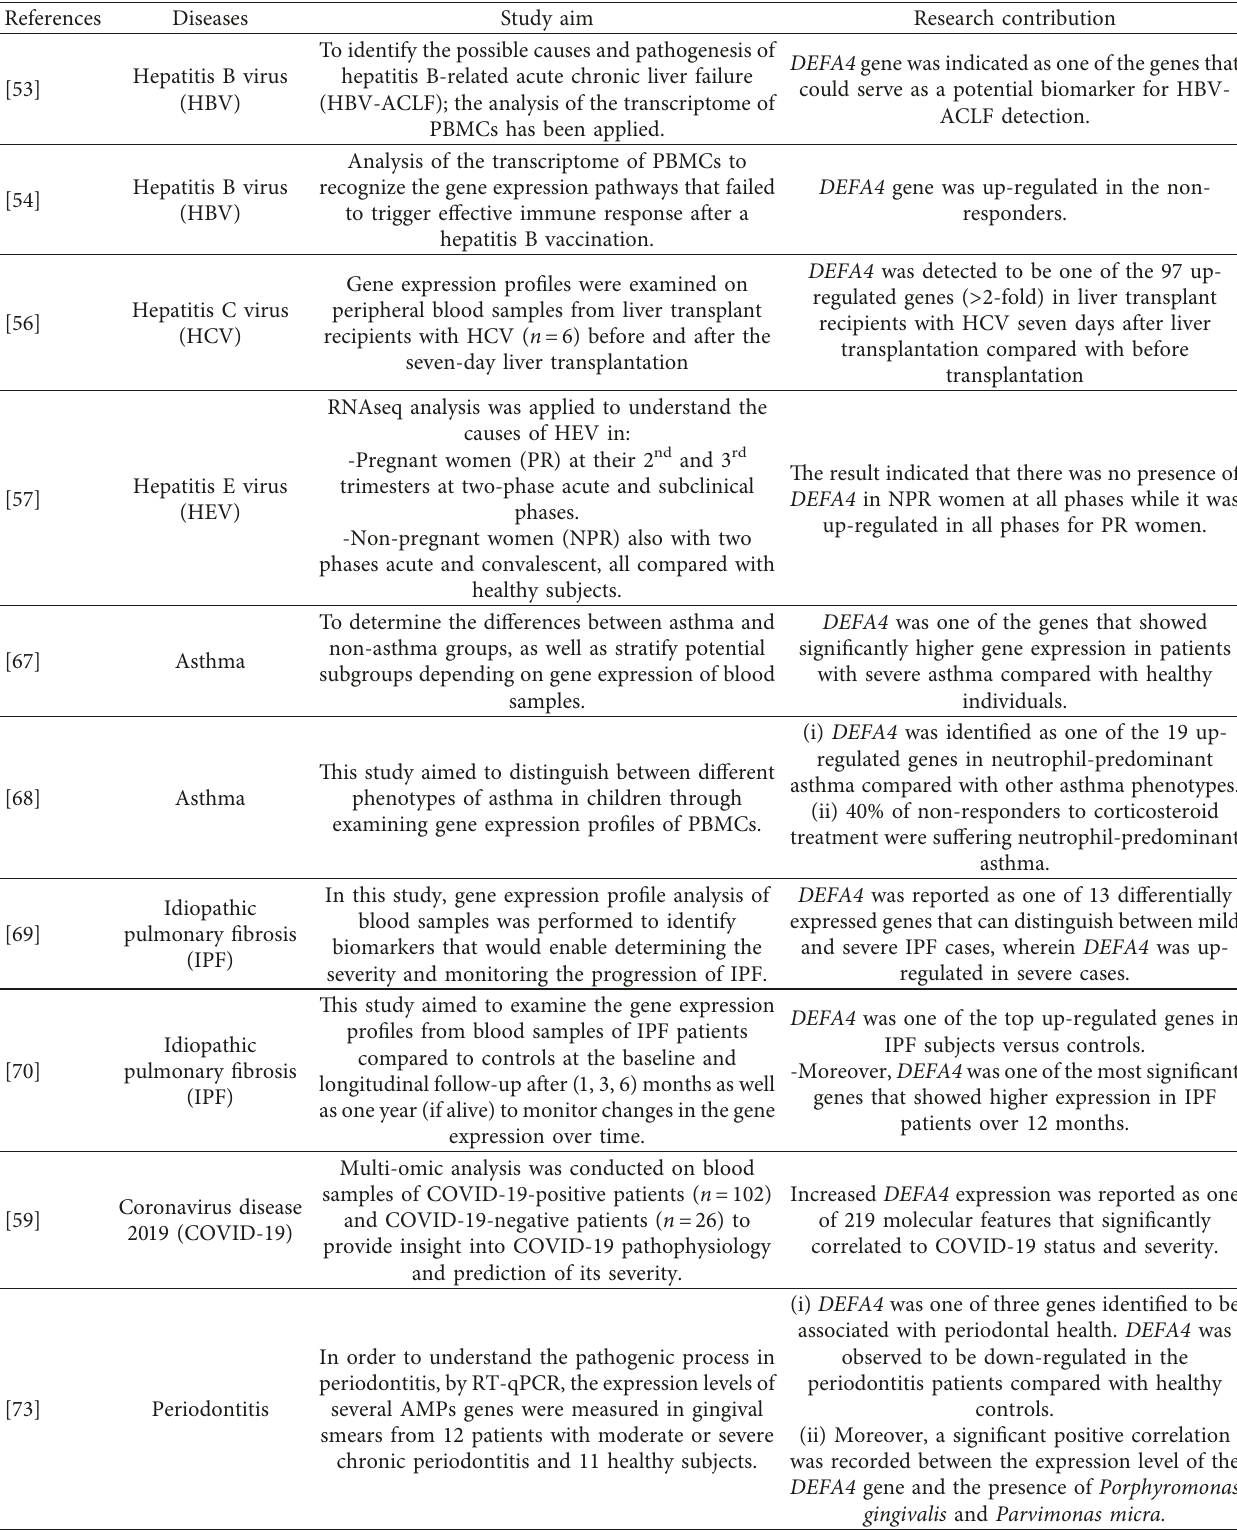
Table 1: List of studies that indicated an alteration in DEFA4 gene expression in respiratory-related diseases, periodontitis, liver-related diseases, autoimmune